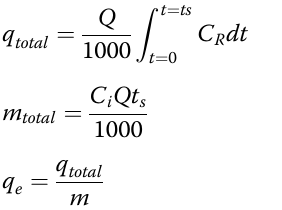
where α is a solvent association parameter, M (g mol − 1 ) is the molecular weight of the solvent, and V m (cm 3 mol − 1 ) is the molar volume of SMX at its normal boiling point (see Table 1). Since the intraparticle diffusion in- volves both surface and pore diffusion, both mechanisms can be represented by an effective intraparticle diffusion coefficient ( D e ), Eq. (12) [23].